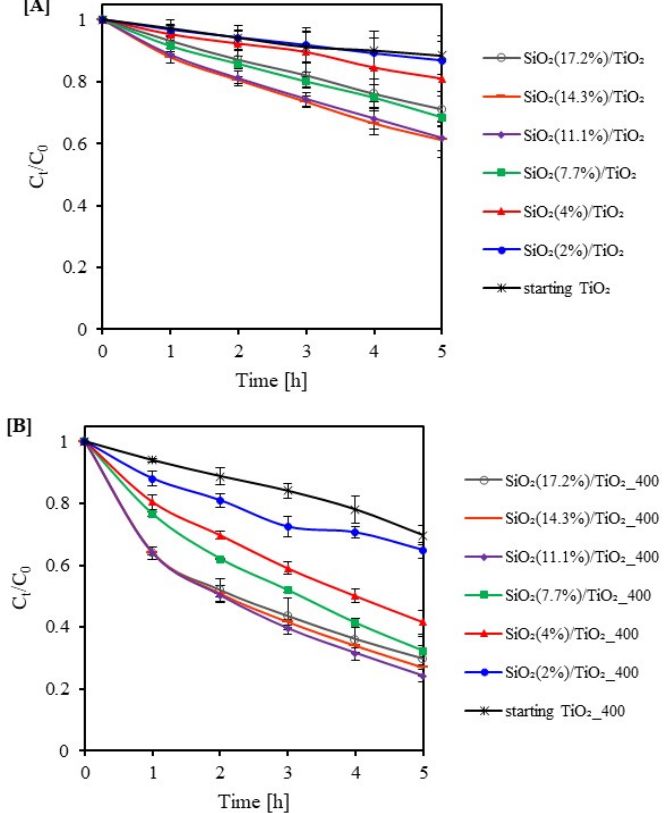
Figure 8. Methylene blue decomposition under UV irradiation of starting TiO 2 and silica-modified TiO 2 prior ( A ) and after calcination at 400 °C ( B ).